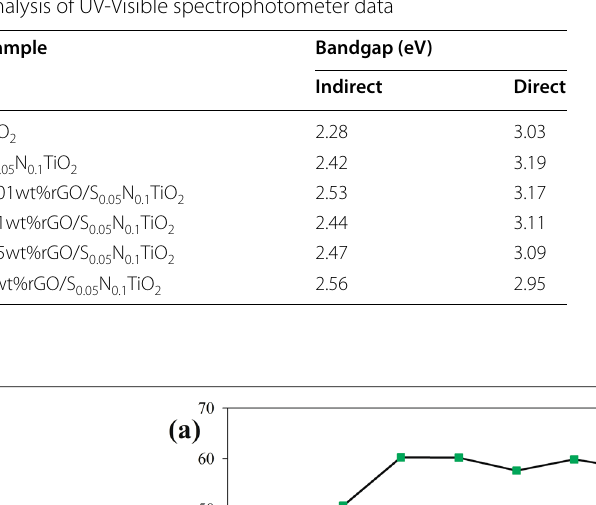
Figure 5 and Fig. S3 display the optical properties of photocatalyst as the result from UV-Visible spectrometry analysis along with the Table 2 for the direct and indirect band-gap. Compared to bare TiO 2 , a noticeable shift of absorption edge was demonstrated by the S, N-doped Table 2 Direct and indirect bandgap of the samples from the analysis of UV‑Visible spectrophotometer data Sample Bandgap (eV)